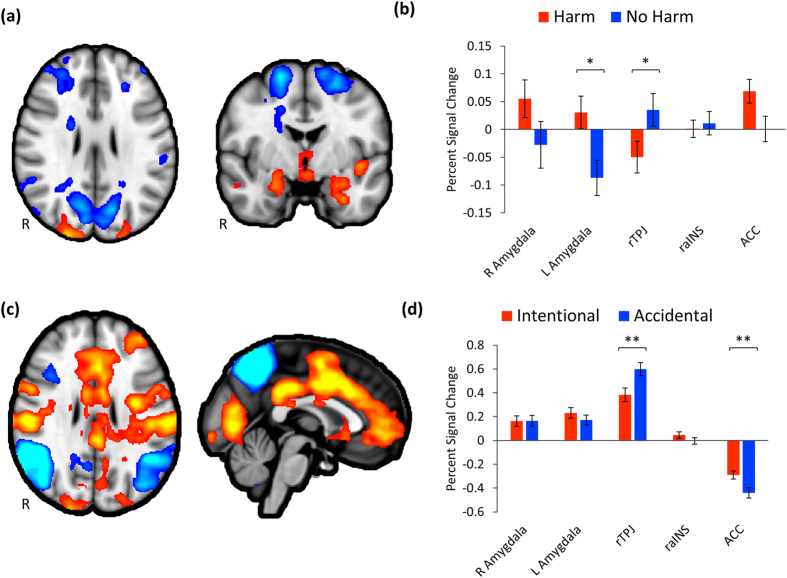
Group level results.Significant regions (corrected cluster p < 0.05) for the whole-brain contrast Harm – No Harm (a) and for a priori regions of interest (b). Harm – NoHarm became marginally significant in ACC (q = 0.071) after correcting for multiple comparisons. (c) Significant regions (corrected cluster p < 0.05) for the whole-brain contrast Intentional – Accidental and for a priori regions of interest (d). Error bars represent SEM. *FDR-corrected p < 0.05, **FDR-corrected p < 0.01.